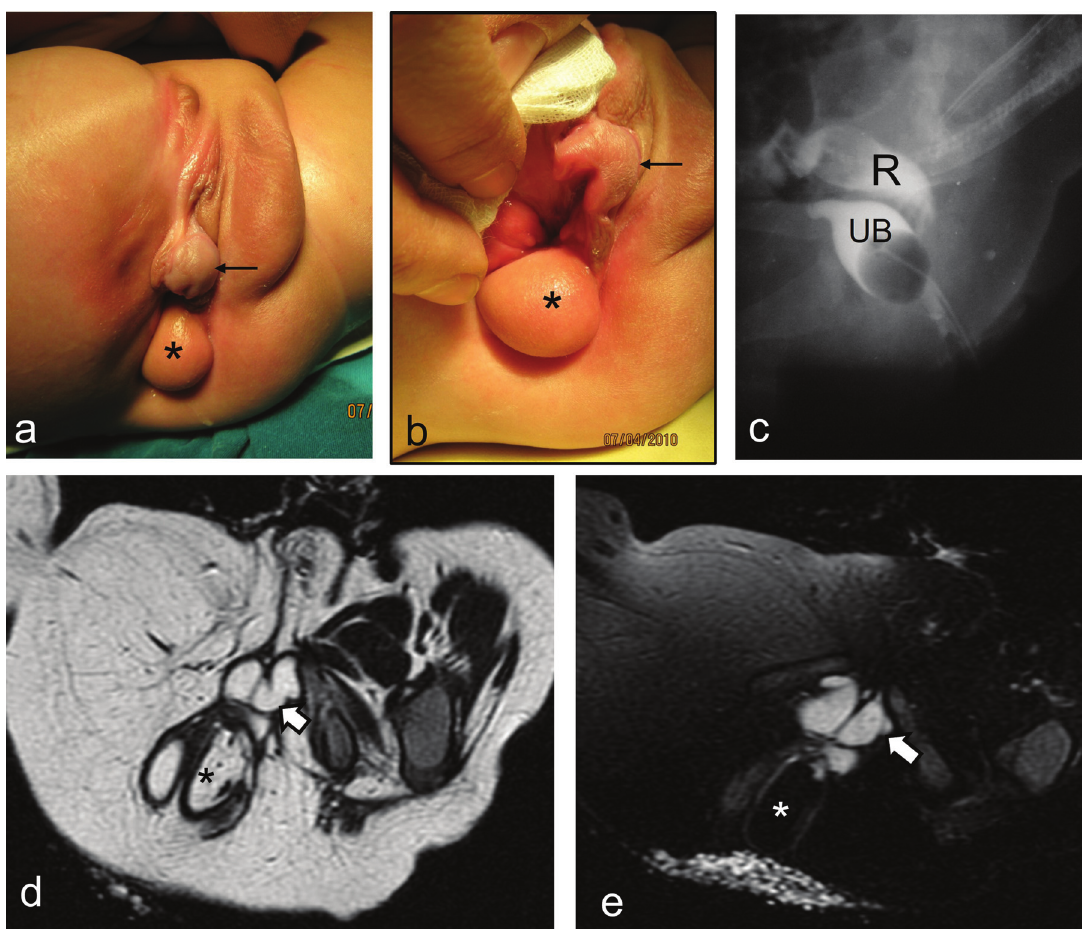
Fig. 1 First case: ( A, B ) Clinical examination of the perineum (at the age of 7 months) demonstrates the caudally displaced hypospadiac phallus (black arrow), single “ central ” perineal ori fi ce, and perineal lipoma (asterisk). Note: empty right scrotal compartment. ( C ) Contrast X-ray study: injection of contrast through distal colostomy demonstrating the rectum (R) that was not communicating with the urinary bladder (UB); the latter was opaci fi ed through separate contrast injection through perineal ori fi ce. ( D ) Axial T2-weighted imaging (T2WI; pelvic magnetic resonance imaging [MRI]) demonstrating perineal lipoma (asterisk). Note the characteristic bending of the corpora cavernosa of the penis (thick white arrow), and the atrophy of the skeletal muscles of the hypoplastic right lower limb. ( E ) Axial T2WI (pelvic MRI) with fat suppression con fi rming the lipomatous nature of the perineal swelling (asterisk). Note: thick white arrow is pointing to corpora cavernosa of the